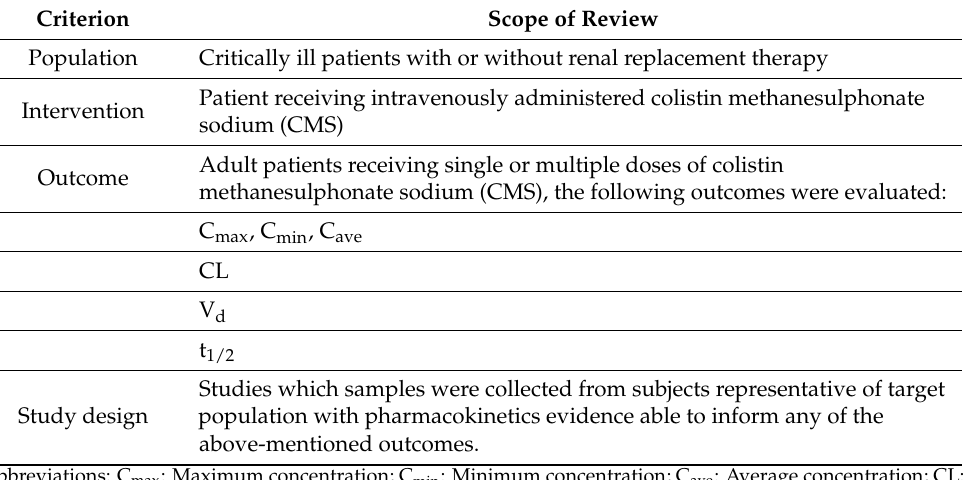
Table 1. Scope of literature